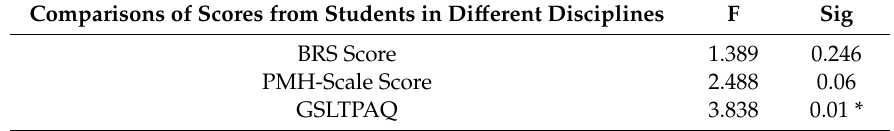
Table 4. Comparisons between students from di ff erent disciplines on physical activities, mental health, and